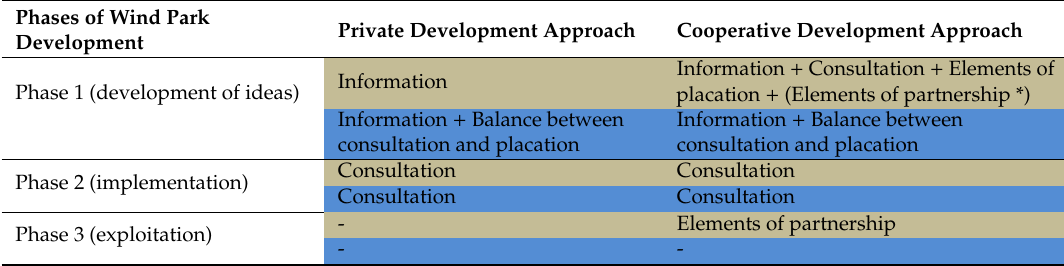
Table 5. Current modes of participation in wind development in Limburg 1